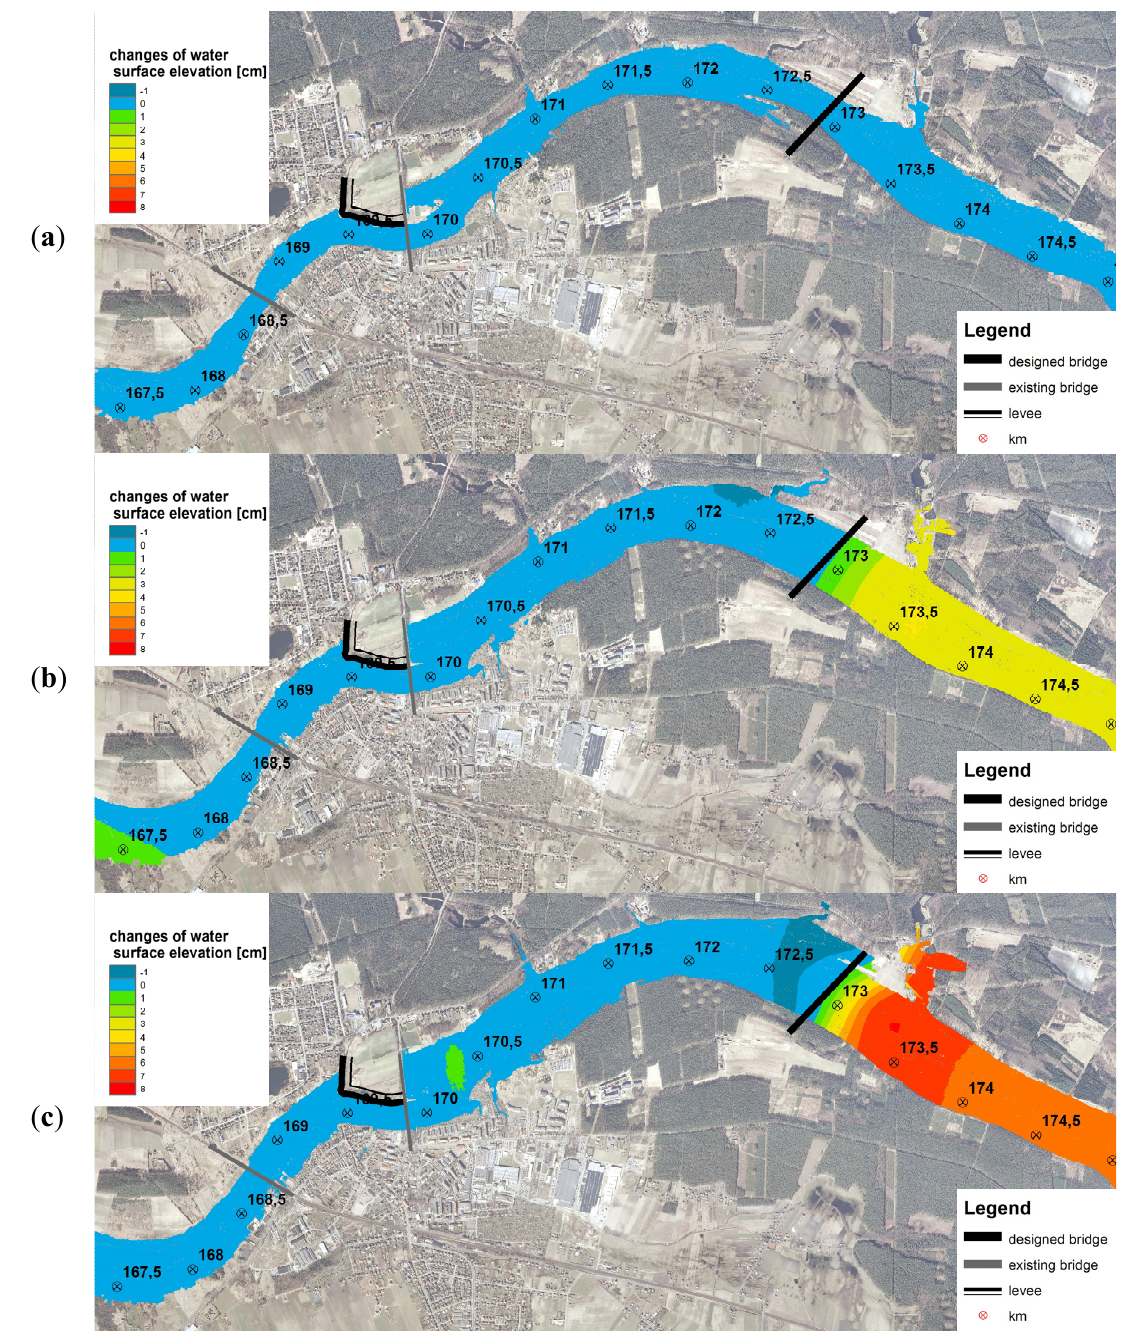
Figure 8. Calculated changes in water surface elevations for maximum flows Q 10% ( a ); Q 1% ( b ) and Q 0.2% ( c